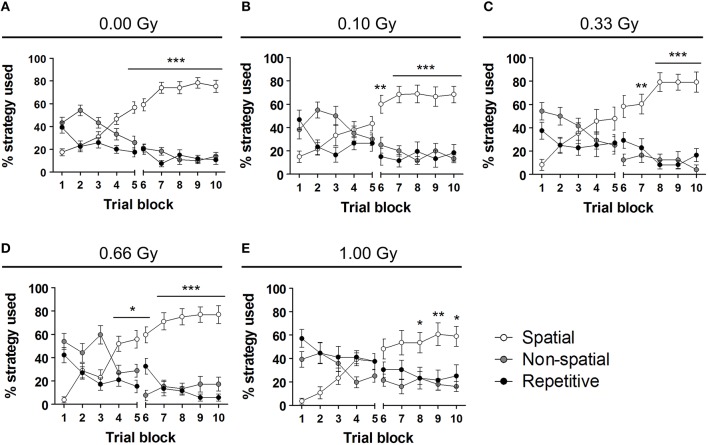
Swim strategy analysis discloses differences in higher cognitive functioning between dose groups. (A–E) We used the analysis of swim strategies in the MWM acquisition trials to uncover subtle dissimilarities in higher spatio-cognitive performance in control animals (A) vs. mice in utero exposed to 0.10 (B), 0.33 (C), 0.66 (D), or 1.00 Gy (E). The exclusive use of the spatial strategy in sham-exposed mice from day 5 onwards was not found in the other dose groups. Indeed, mice irradiated with 0.10 Gy only showed this predominant spatial strategy use from training day 6 on and 0.33-Gy irradiated mice from day 7 on. The most pronounced differences in this analysis were observed in the animals exposed to the highest dose of 1.00 Gy (exclusive use of spatial strategy from day 8 on). Conflicting to this dose-response relationship, the 0.66-Gy exposed animals already significantly used their spatial strategy as compared to the other two strategy classes from training day 4 onwards. Data are presented as mean ± SEM. Horizontal lines with an asterisks indicate significant differences between the spatial vs. non-spatial and repetitive strategies for all the trial blocks underneath. *P < 0.05, **P < 0.01, ***P < 0.001. Gy, Gray; MWM, Morris water maze.